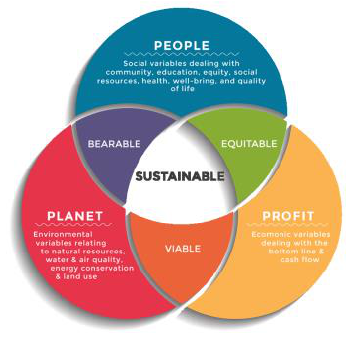
Figure 2. Triple bottom line [37].